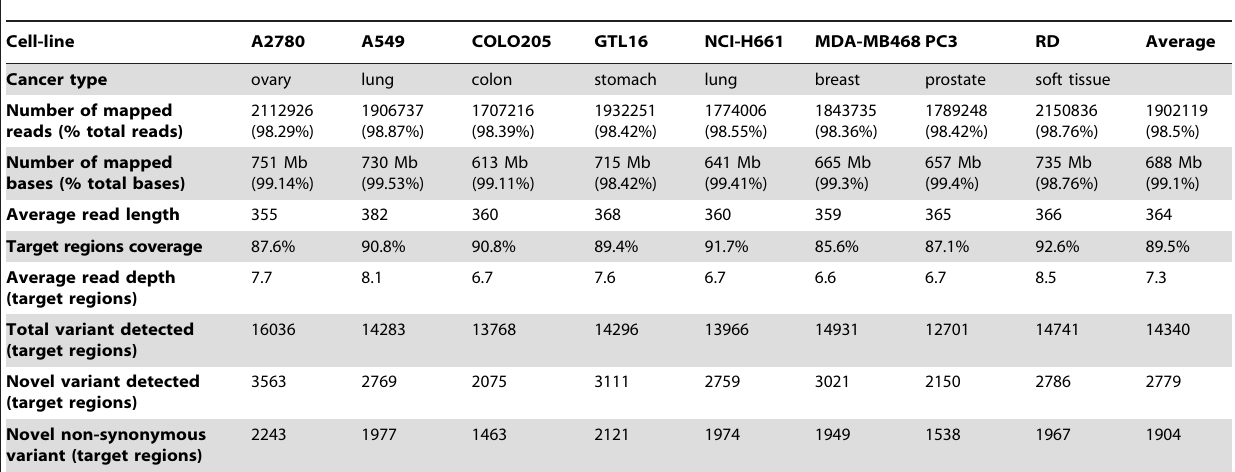
Table 1. Exome capture and sequencing